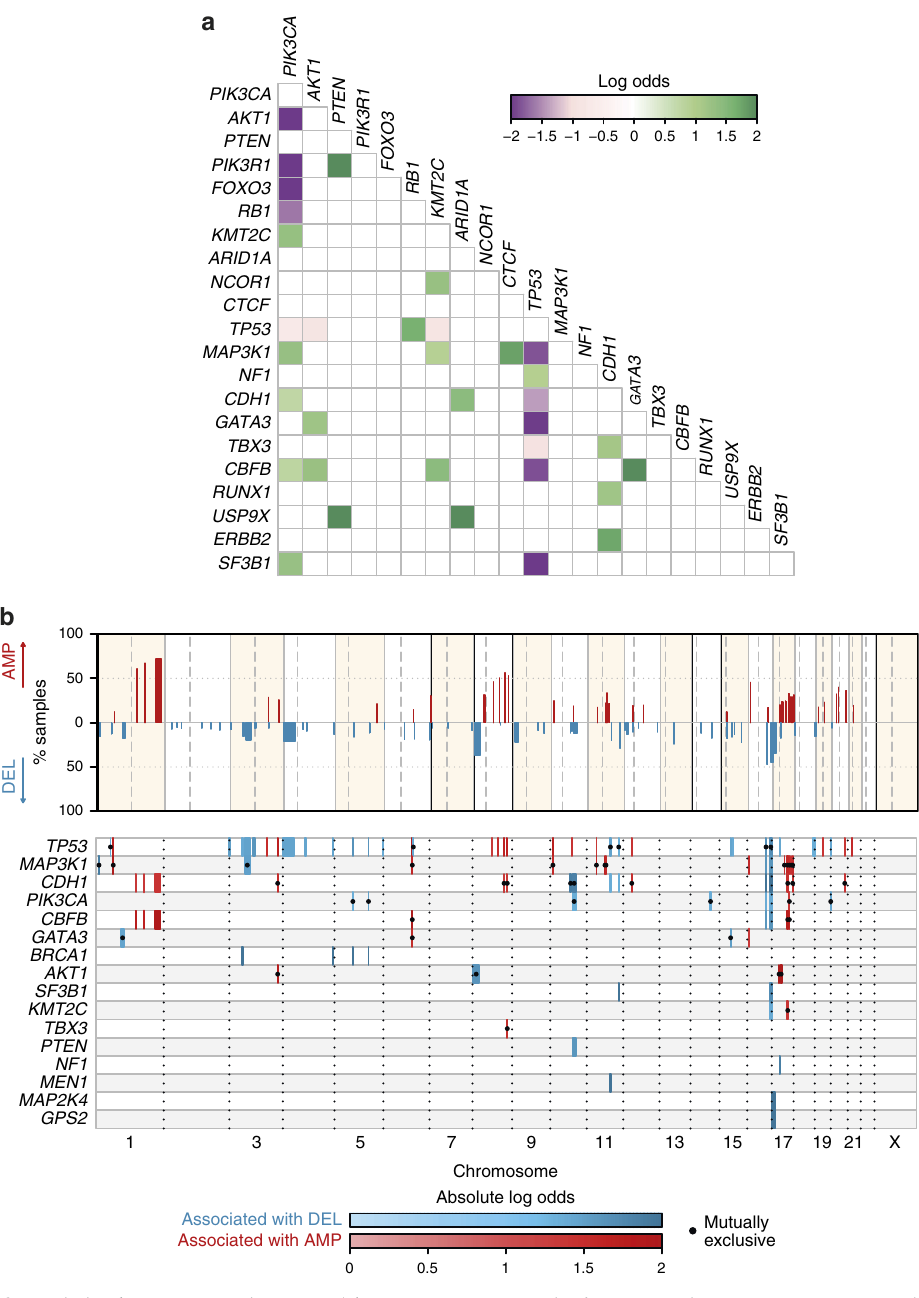
in IntClusts10 (median CCF ¼ 1, interquartile range (IQR) ¼ 1–1, 26 mutations) and IntClust9 (median ¼ 1, IQR ¼ 0.98–1, 49 mutations) were present at CCFs close to 1, whereas some PIK3CA mutations in IntClust3 tumours were present in lower CCFs (median ¼ 0.96, IQR ¼ 0.75–1, 215 mutations). IntClusts 2 and 6 are relatively small subgroups comprising ER þ cancers